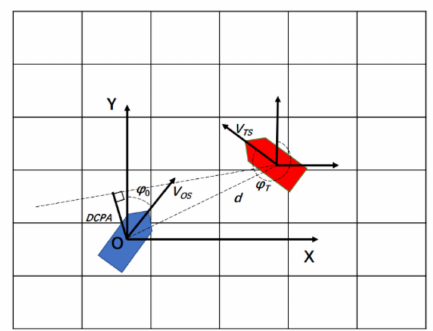
Figure 5. Ship conflict node search graph.